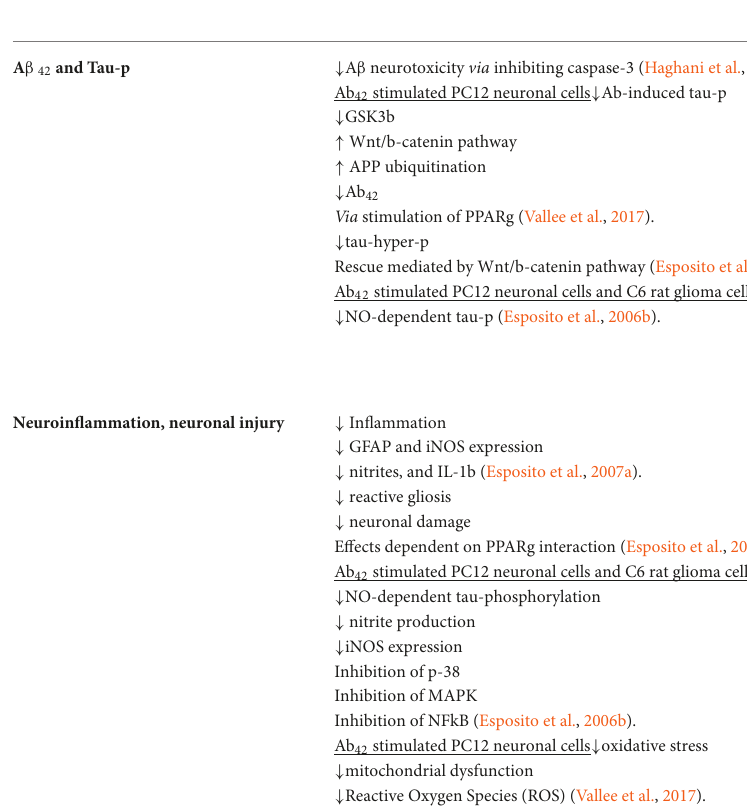
TABLE 3 Influence of CBD/THC on in vitro /non-ad models of Alzheimer’s disease-related neuropathology.